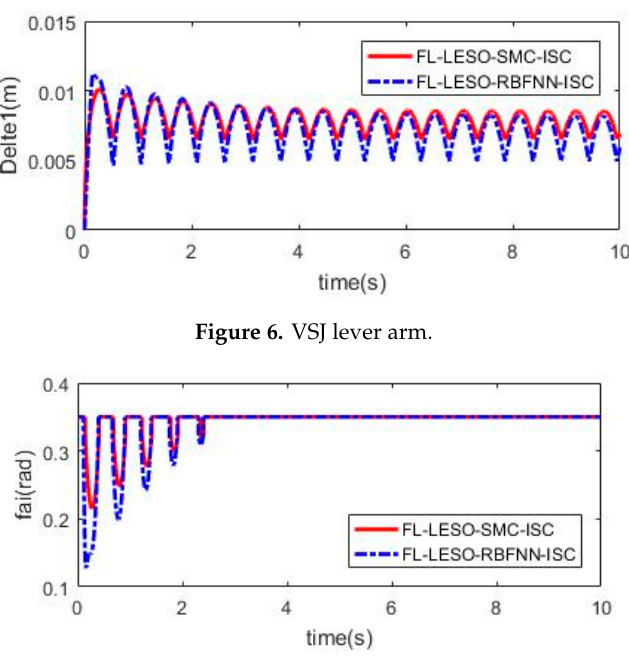
Figure 7. VSJ angle deviation.